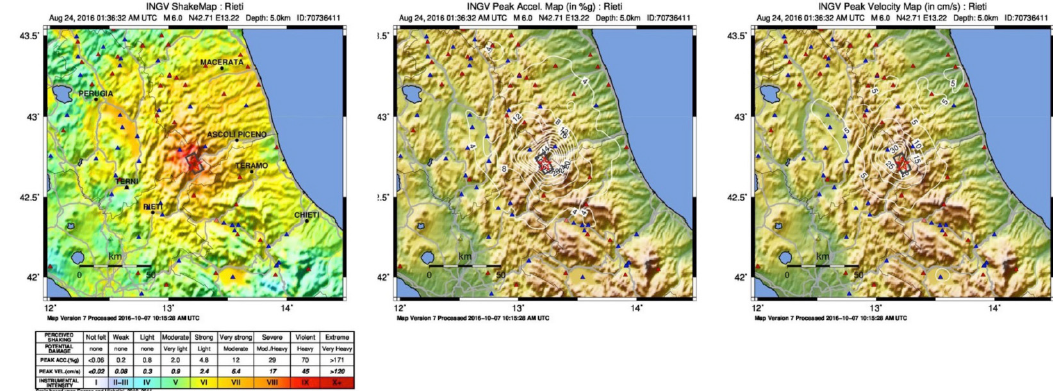
Figure 2. The Shakemaps of the main shock as in Figure 1 after inserting the fault. Left: MCS derived instrumental in- tensity; Center: PGA; Right: